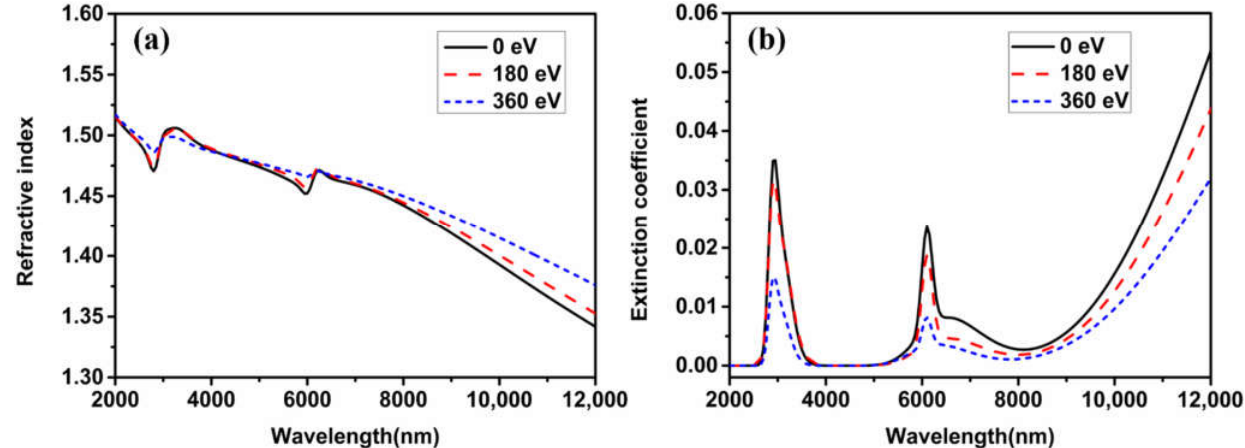
Figure 7. Optical constants of YbF 3 films from 2000 nm to 12,000 nm. ( a ) Refractive index. ( b ) Extinction coefficient.